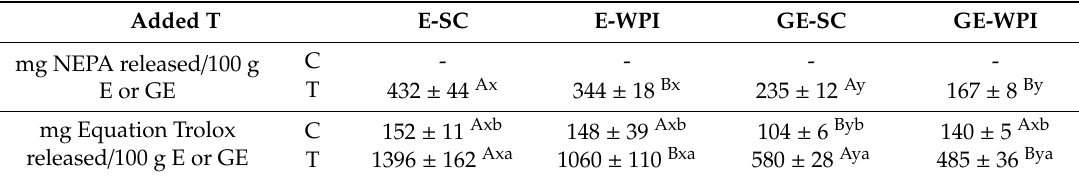
Table 3. Non-extractable proanthocyanidins (NEPA) released (mg / 100 g) and antioxidant activity (mg Equation Trolox / 100 g) after simulated gastrointestinal in vitro digestion of the di ff erent emulsions developed. Added T E-SC E-WPI GE-SC GE-WPI C - - - - mg NEPA released / 100 g T 432 ± 44 Ax 344 ± 18 Bx 235 ± 12 Ay 167 ± 8 By E or GE mg Equation Trolox C 152 ± 11 Axb 148 ± 39 Axb 104 ± 6 Byb 140 ± 5 Axb released / 100 g E or GE T 1396 ± 162 Axa 1060 ± 110 Bxa 580 ± 28 Aya 485 ± 36 Bya Values are given as mean ( n = 3) ± standard deviation. Di ff erent letters in the same row (A, B) indicate significant di ff erences ( p < 0.05) as a function of EP (SC, WPI) for each emulsion structuration level (E, GE). Di ff erent letters in the same row (x, y) indicate significant di ff erences ( p < 0.05) as a function of cold gelation (E, GE) for each EP (SC, WPI). Di ff erent letters in the same column (a, b) indicate significant di ff erences ( p < 0.05) as a function of